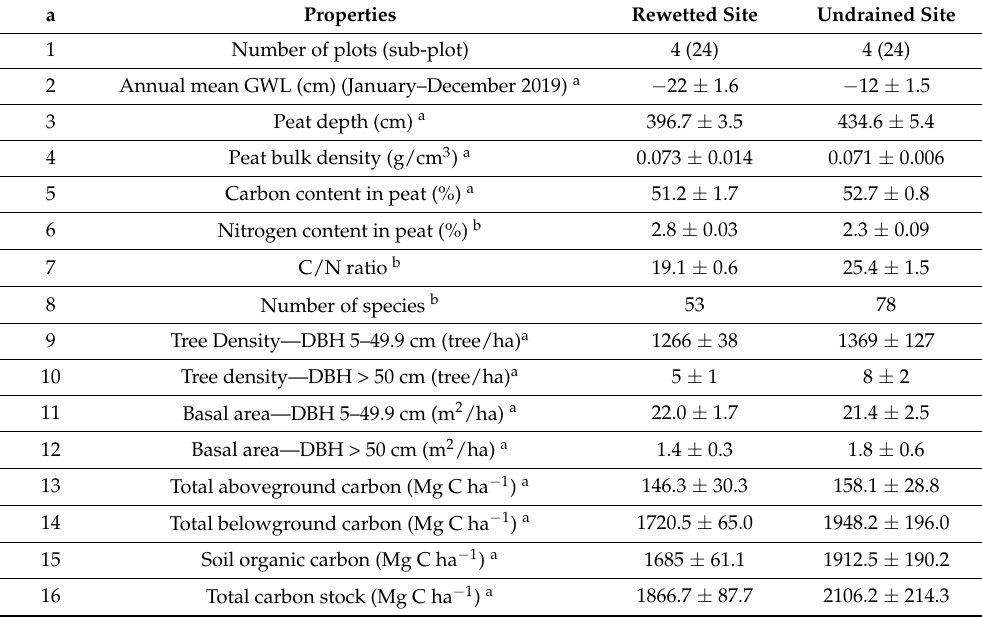
Figure 4. Aboveground carbon (AGC) and belowground carbon (BGC) stocks of the rewetted and undrained PSF plots and the contribution from each carbon pool component. Table 1. Biophysical properties and carbon stock of the study sites (mean ±